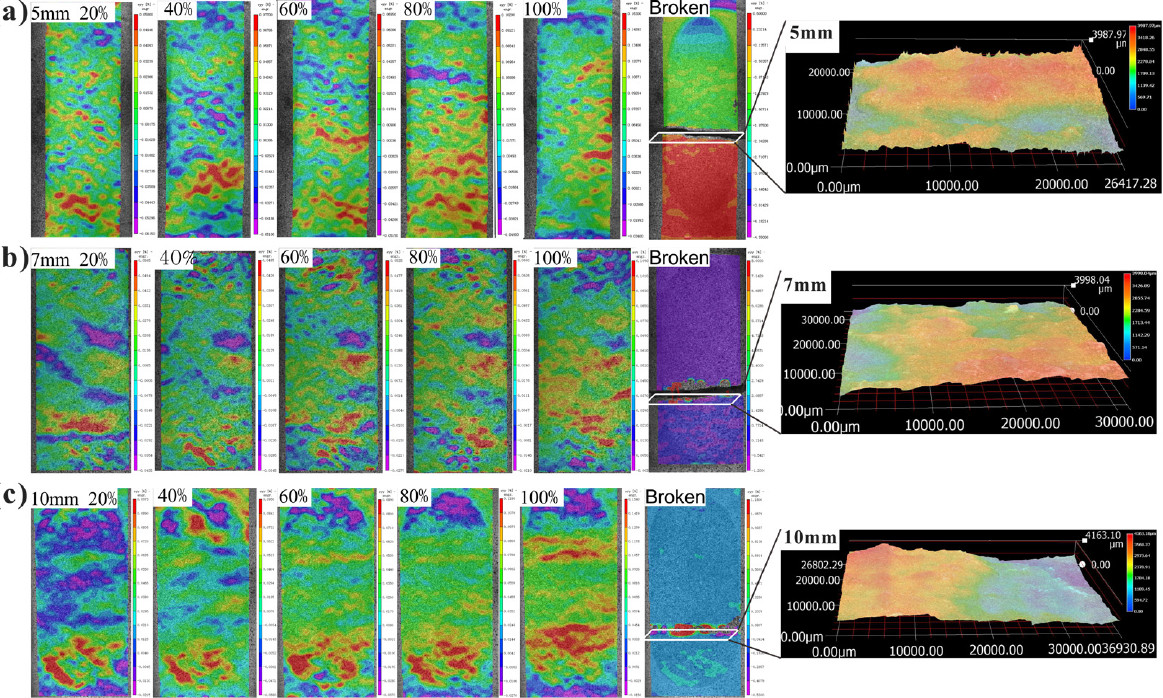
Figure 7. Strain evolution of the specimens in DTT monitored by digital image correlation (DIC) and micro-topographies of the fractured sections: ( a ) t = 5 mm, ( b ) t = 7 mm, ( c ) t = 10 mm. Table 2. Micro-characteristic parameters of the fractured section from DTT.